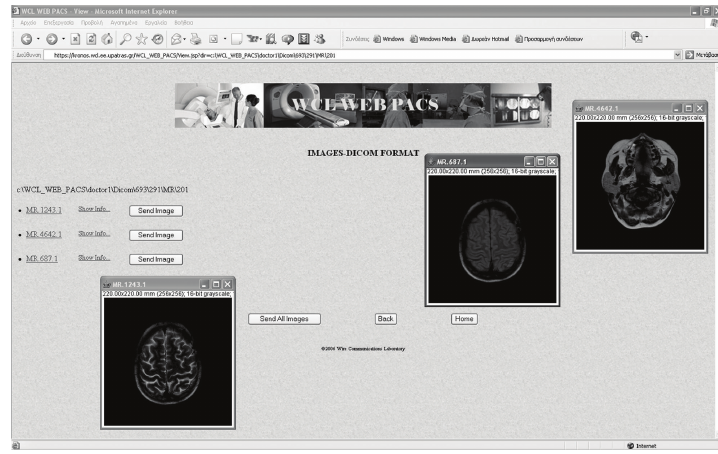
Figure 6: User interface of the DICOM View service—Java applets embedded in